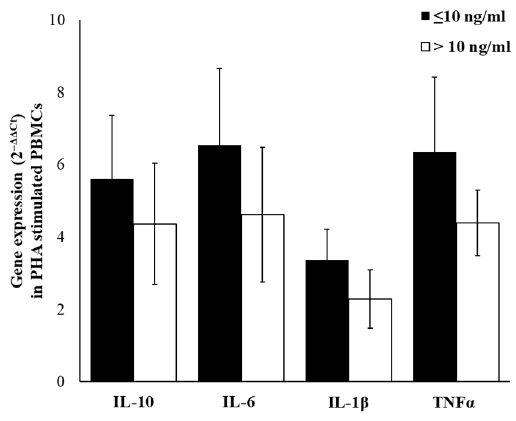
Figure 5. PHA-induced cytokine expression. IL-10, IL-6, IL-1 β , and TNF α gene expression in PHA-stimulated PBMCs of enrolled workers with salivary cortisol levels ≤ or > of 10 ng / mL. Data are reported as mean 2 - ΔΔ Ct ± SE.